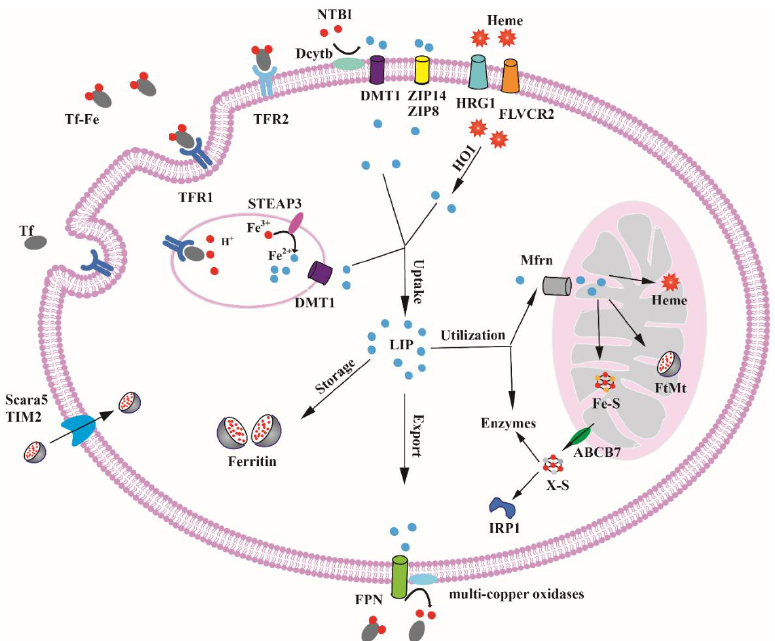
Figure 1. Iron metabolism in mammalian cells. Transferrin-bound ferric iron enters most cells via TFR1-mediated endocytosis. Iron is freed from transferrin and reduced to ferrous iron by STEAP3 in endosomes. Further, ferrous iron is transported across the endosomal membrane to the cytosol via DMT1; TFR1 and apotransferrin (apoTf) return to the cytomembrane for further cycles. NTBI enters cells also through DMT1 after reduced by Dcytb. Ferritin is also taken up by cells via Scara5 and TIM2. Other iron acquisition pathways in specific cell types via TFR2, ZIP8, ZIP14, HRG1 and FLVCR2 are symbolized. The acquired iron enters into the cytosolic LIP. Then, iron is utilized for synthesizing iron proteins or transported to mitochondria via Mfrn, where the metal is inserted into heme and Fe-S clusters or stored in FtMt. The fraction of the LIP can be exported via ferroportin or stored in ferritin.